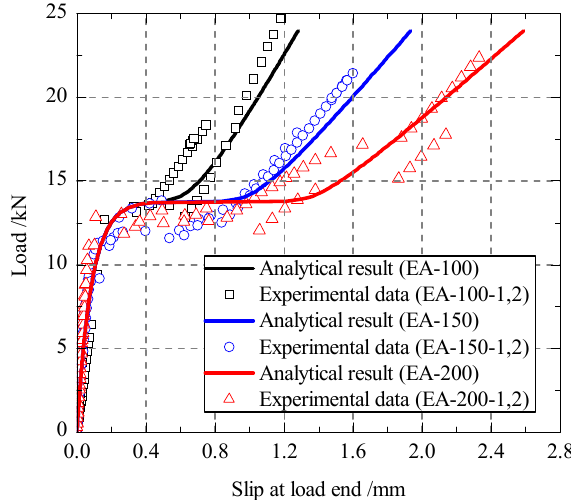
Figure 10. Load-slip response.